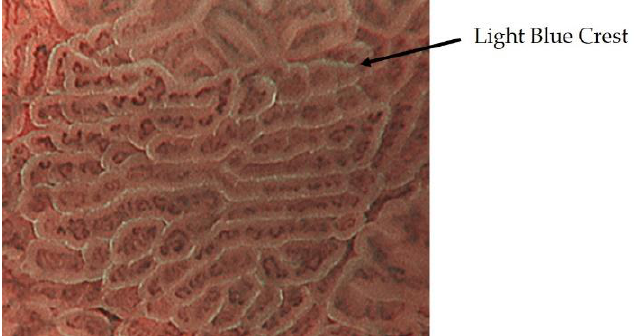
Figure 3. The intestinal metaplasia observed as a blue-white border by ME-NBI.